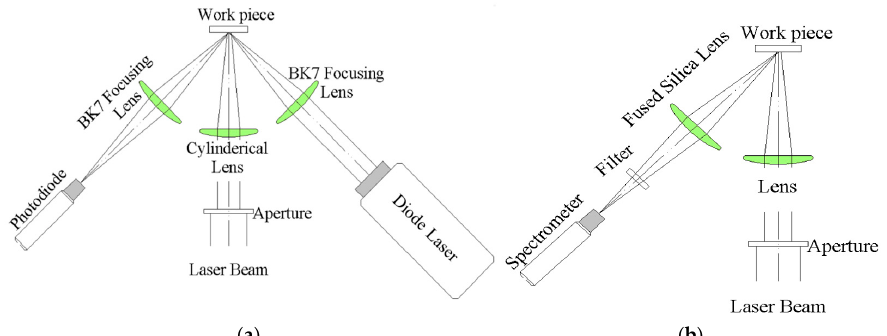
Figure 2. Schematic illustration of the online monitoring arrangements, ( a ) For the probe beam reflection (PBR), ( b ) For the laser plume emission spectroscopy.